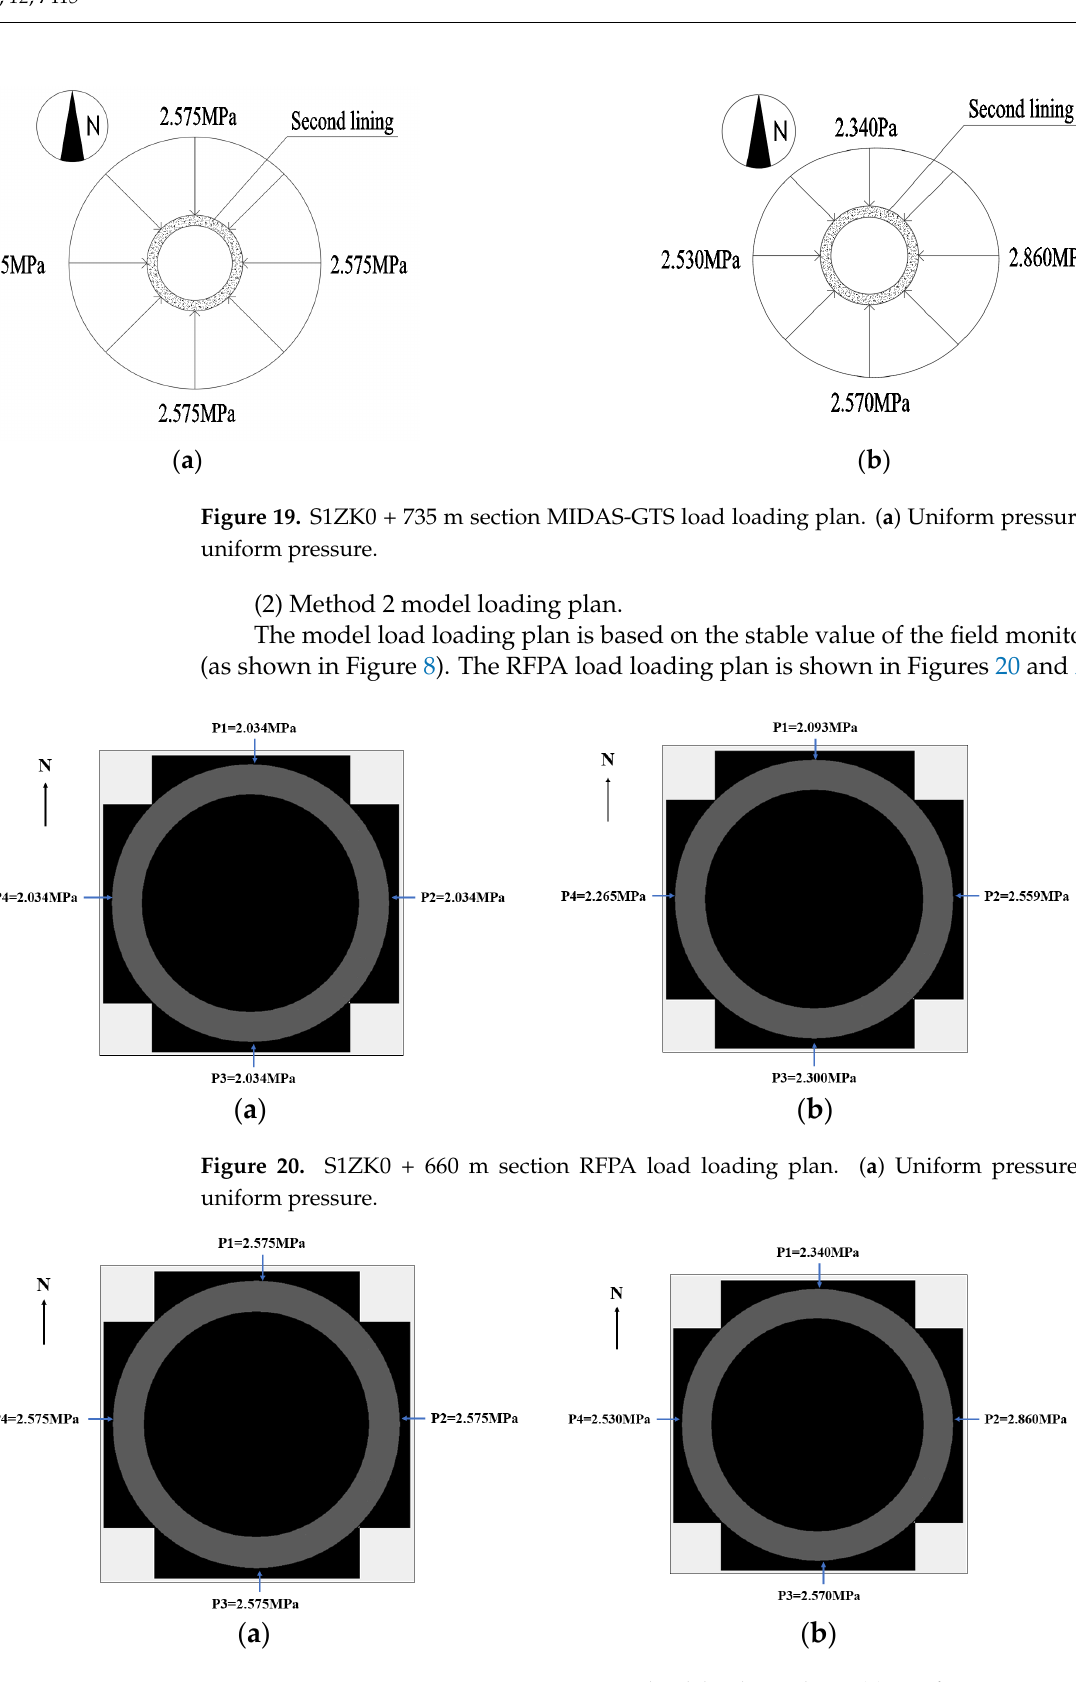
( d ) Figure 22. Simulated internal force of S1ZK0 + 660 m section. ( a ) Non ‐ uniform axial force diagram; ( b ) Non ‐ uniform bending moment diagram; ( c ) Uniform axial force diagram; ( d ) Uniform bending moment diagram. It can be seen from Figure 22, that under the action of non ‐ uniform pressure, the maximum bending moment of the lining was 257.4 kN m, and the corresponding axial force was 7198 kN. Under the action of uniform pressure, the maximum bending moment of the lining was 41.2 kN ∙ m, and the corresponding axial force was 6775 kN. The bending moment and axial force were substituted into the formula to obtain the safety factor of the lining structure, as shown in Table 4.